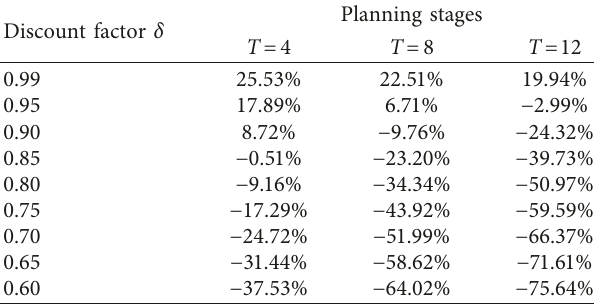
Table 8: Estimation gaps of the DE model.